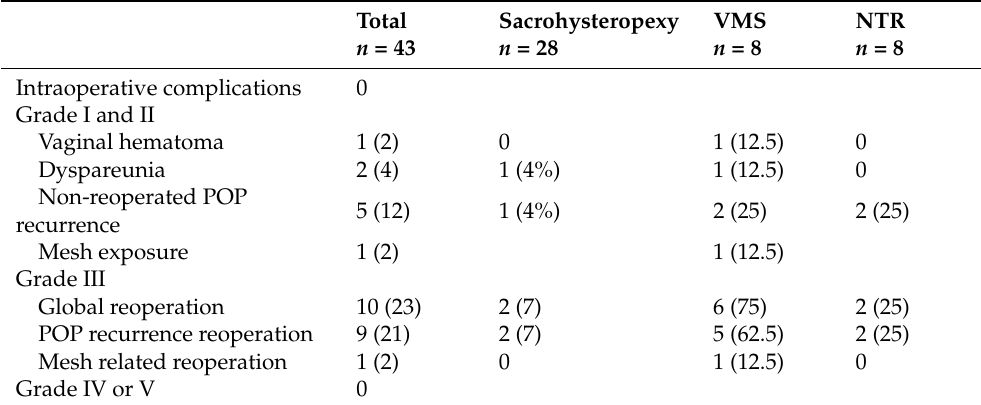
Table 2. Long-term complications according to the Clavien–Dindo classification after a POP repair in women under 40 years old.